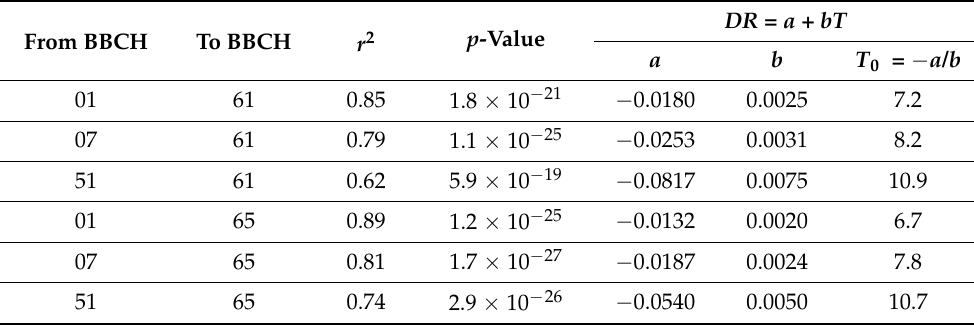
Figure 5. Calibration of DR s for cross-validated phases (subplots’ headline) using a linear DR function. Black lines: DR function. Statistical evaluation reported in Table 4. Definition of BBCH in Table 2. Symbols in the legend refer to the location of the experimental site (Table 1). Table 4. Final calibration of linear DR s for cross-validated phases . T 0 = base temperature (see Section 2.2.1.).